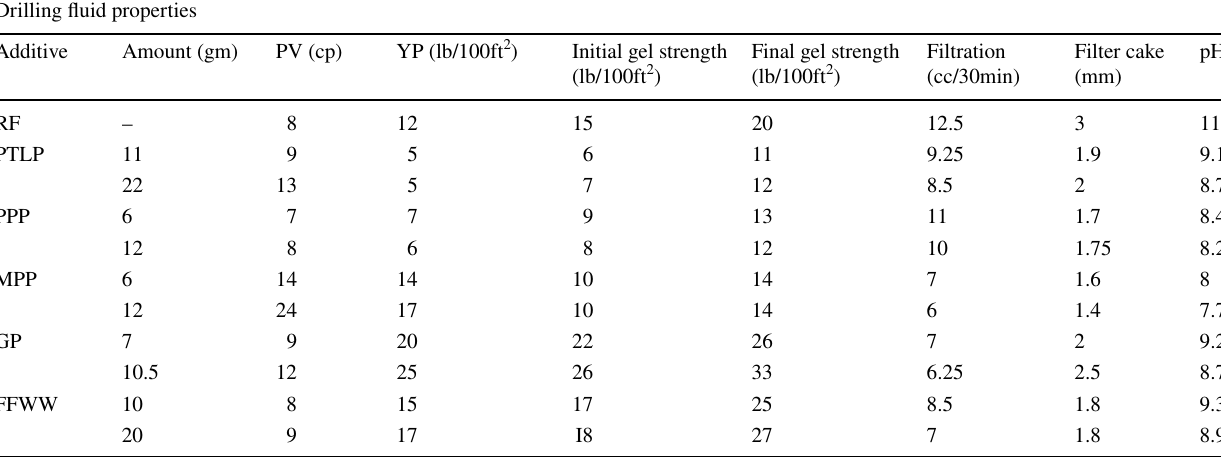
Table 3 Examples of the effects of some waste materials on the drilling fluid properties Drilling fluid